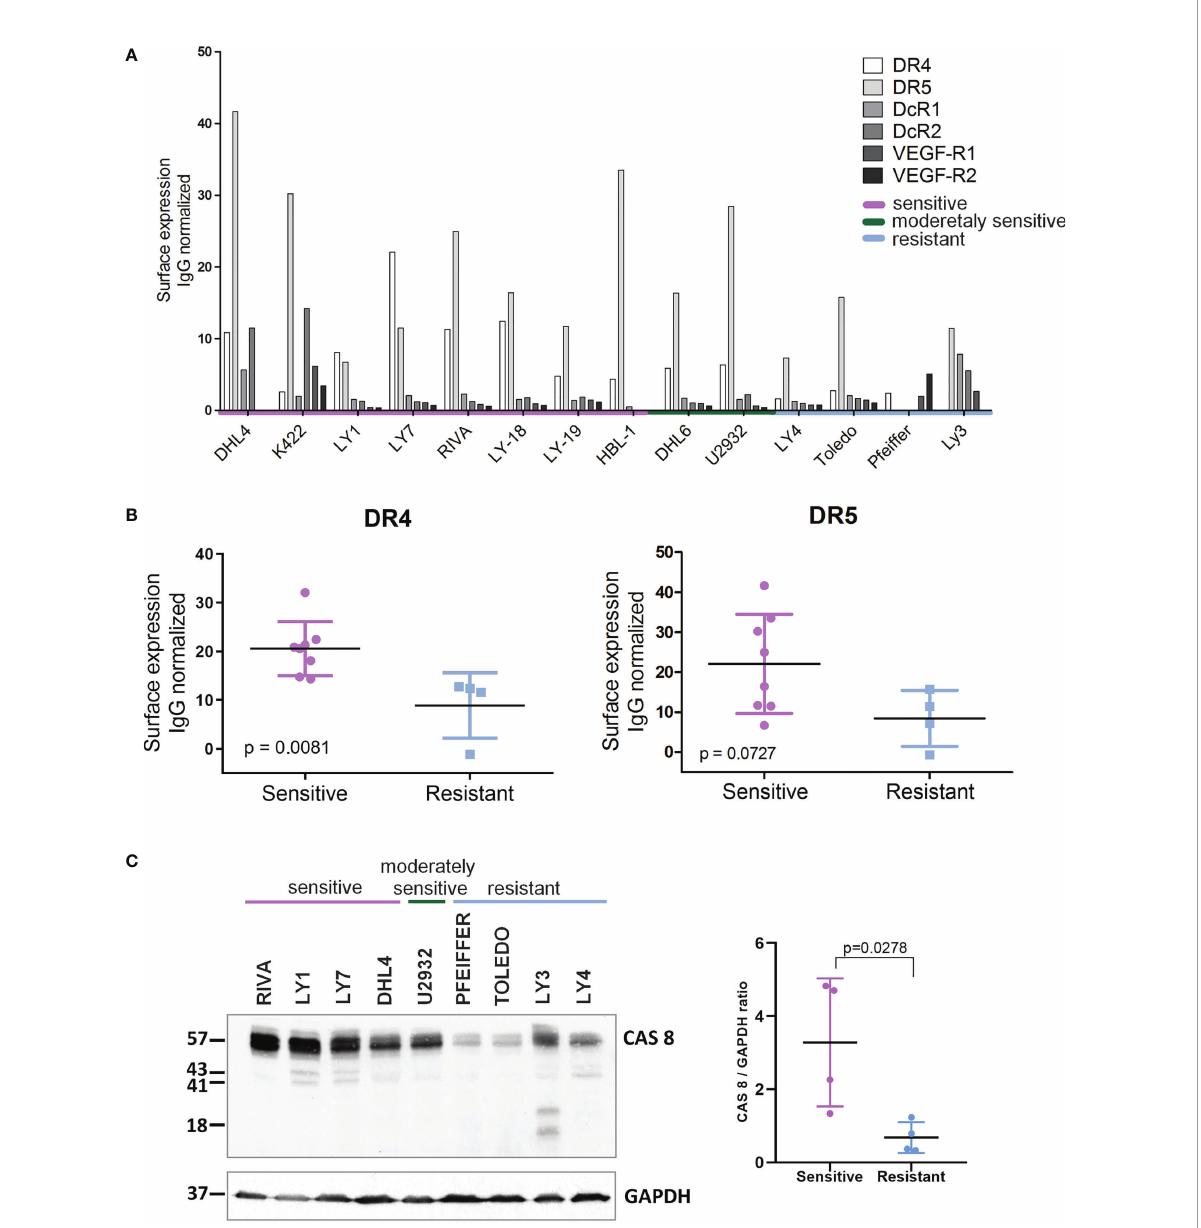
FIGURE 2 Expression of death receptors and caspase 8 is higher in AD-O51.4 – sensitive DLBCL cell lines. (A) Expression of death receptors 4 and 5 (DR4, DR5) decoy receptors 1 and 2 (DcR1, DcR2) and VEGF receptors 1 and 2 (VEGF-R1, VEGF-R2) was assessed in DLBCL cell lines using FACS and appropriate fl uorochrome – conjugated antibodies. Bars indicate isotype control-normalized mean fl uorescence values for each receptor. The bar plot represents the representative of three independent experiments. (B) Comparison of isotype-control normalized MFI values of DR4 and DR5 for AD-O51.4 -sensitive and – resistant DLBCL cell lines. (C) Left panel: expression of caspase 8 in AD-O51.4 -sensitive and – resistant DLBCL cell lines was assessed by immunoblotting. GAPDH served as a loading control. Right panel: CASP8 band intensities were quanti fi ed using pixel densitometry and normalized to GAPDH levels. Differences between sensitive and resistant cell lines were calculated using Student t